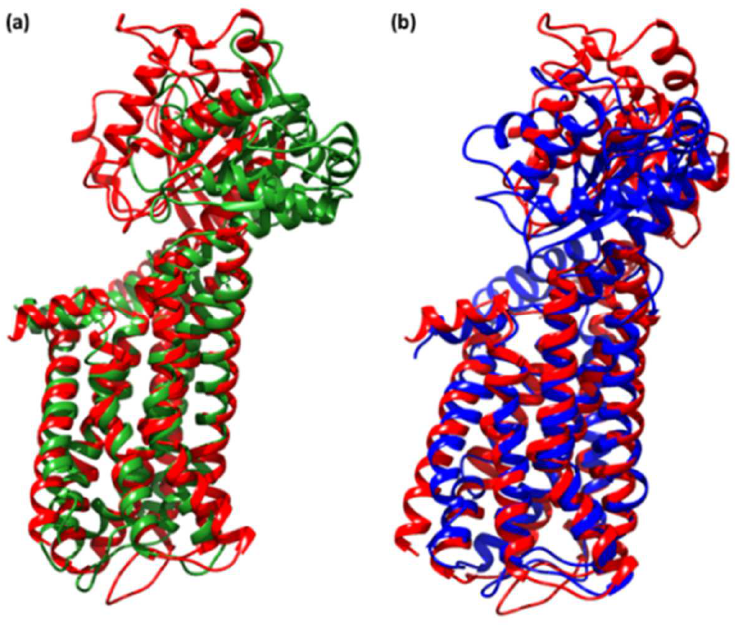
Figure 11. The root mean square deviation (RMSD) of solvated receptor backbone and ligand com- plex during 100 ns MD simulation [SRXD complex (black) and CTcD complex (green)].